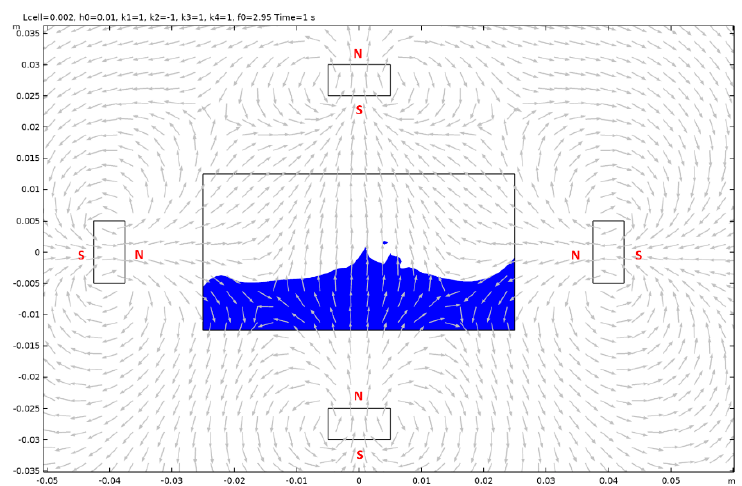
Figure A26. Case 12.